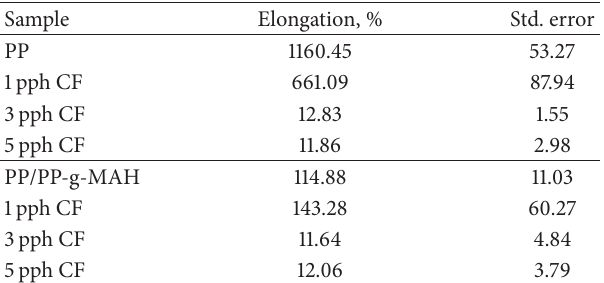
Figure 4: Young’s modulus of injection moulded samples. Table 3: Tensile strain at break of the compression moulded composites.